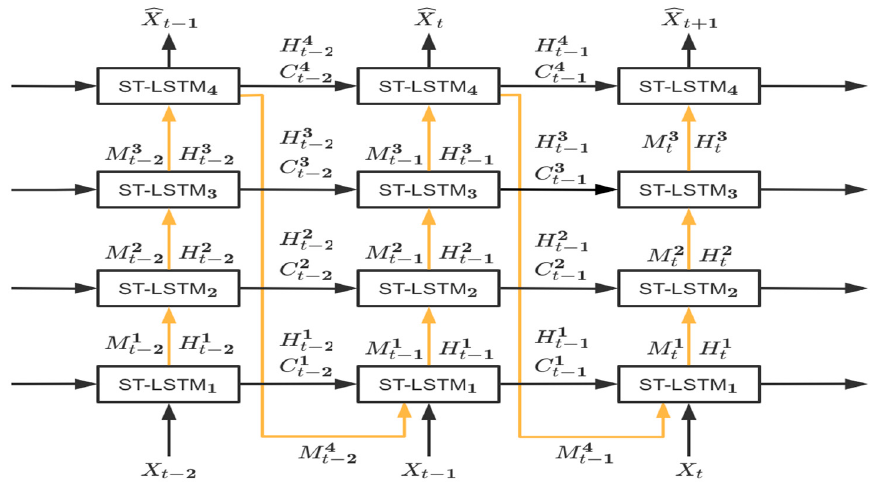
Figure 2. The stacked recurrent neural network of the PredRNN model (The yellow line is for spatial memory transfer, and the horizontal black line is for temporal memory